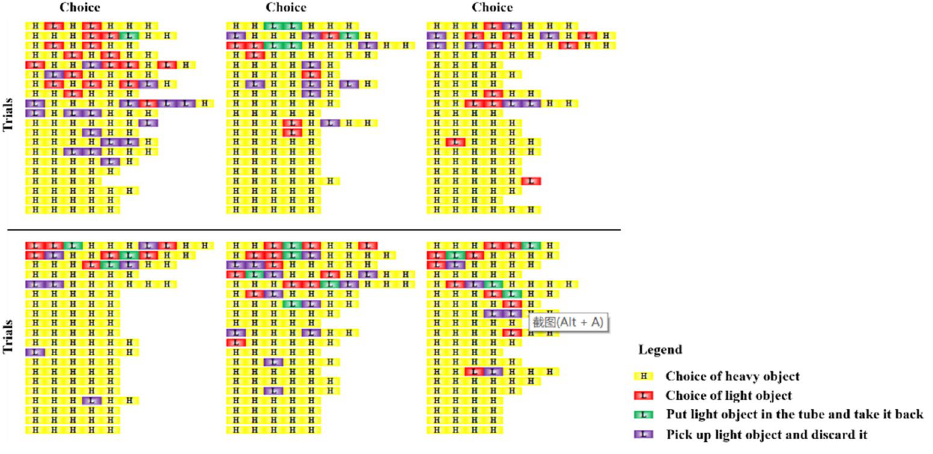
Figure 6. Azure-winged magpies’ choices of objects in experiment